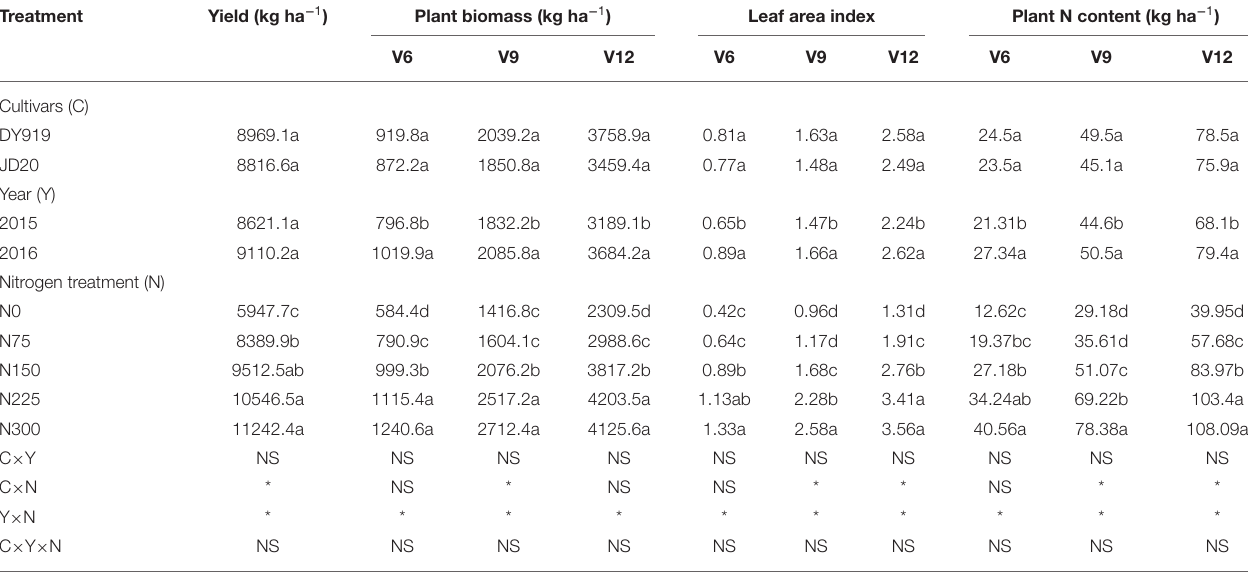
TABLE 2 | Grain yield, plant biomass, leaf area index, and plant N content of two corn cultivars at the three growth stages under five N levels during the 2015 and 2016 seasons.